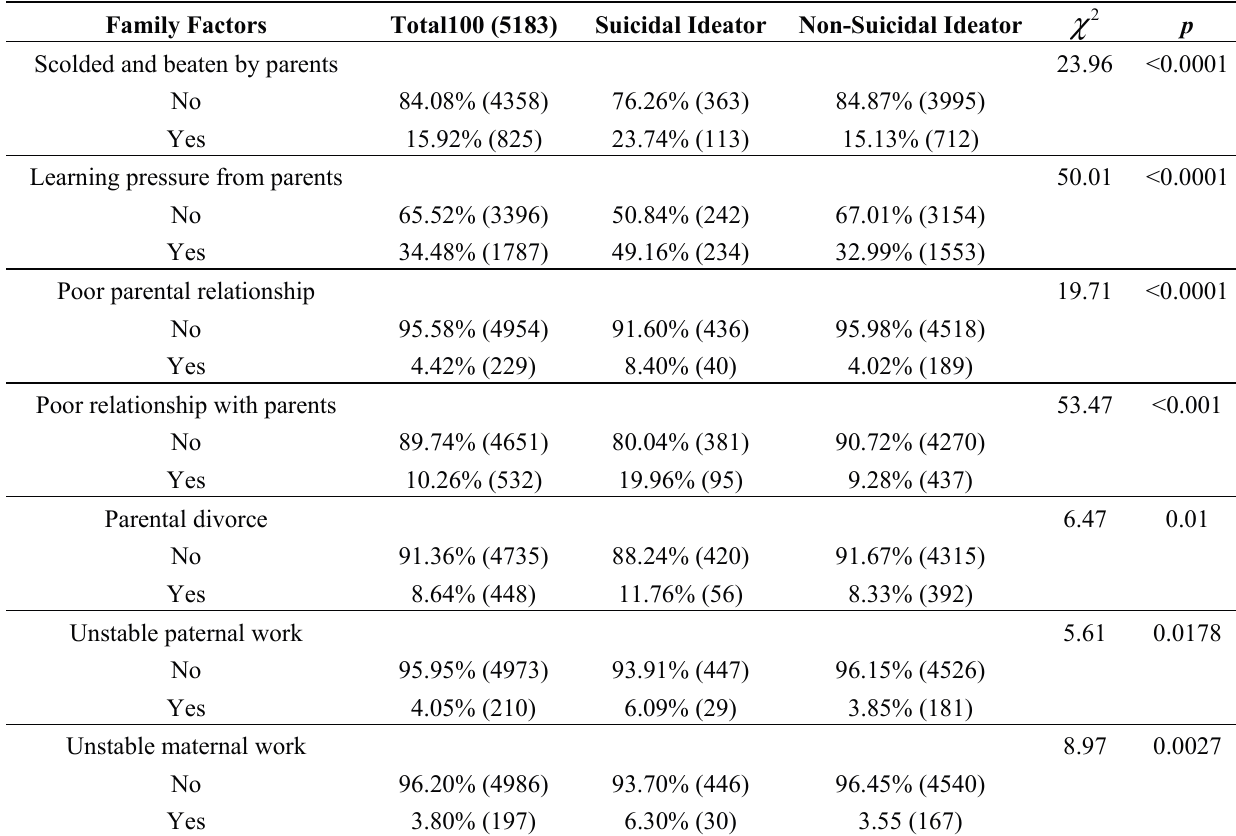
Table 3. Family associated factors of Chinese university students, with and without suicidal ideations. Family